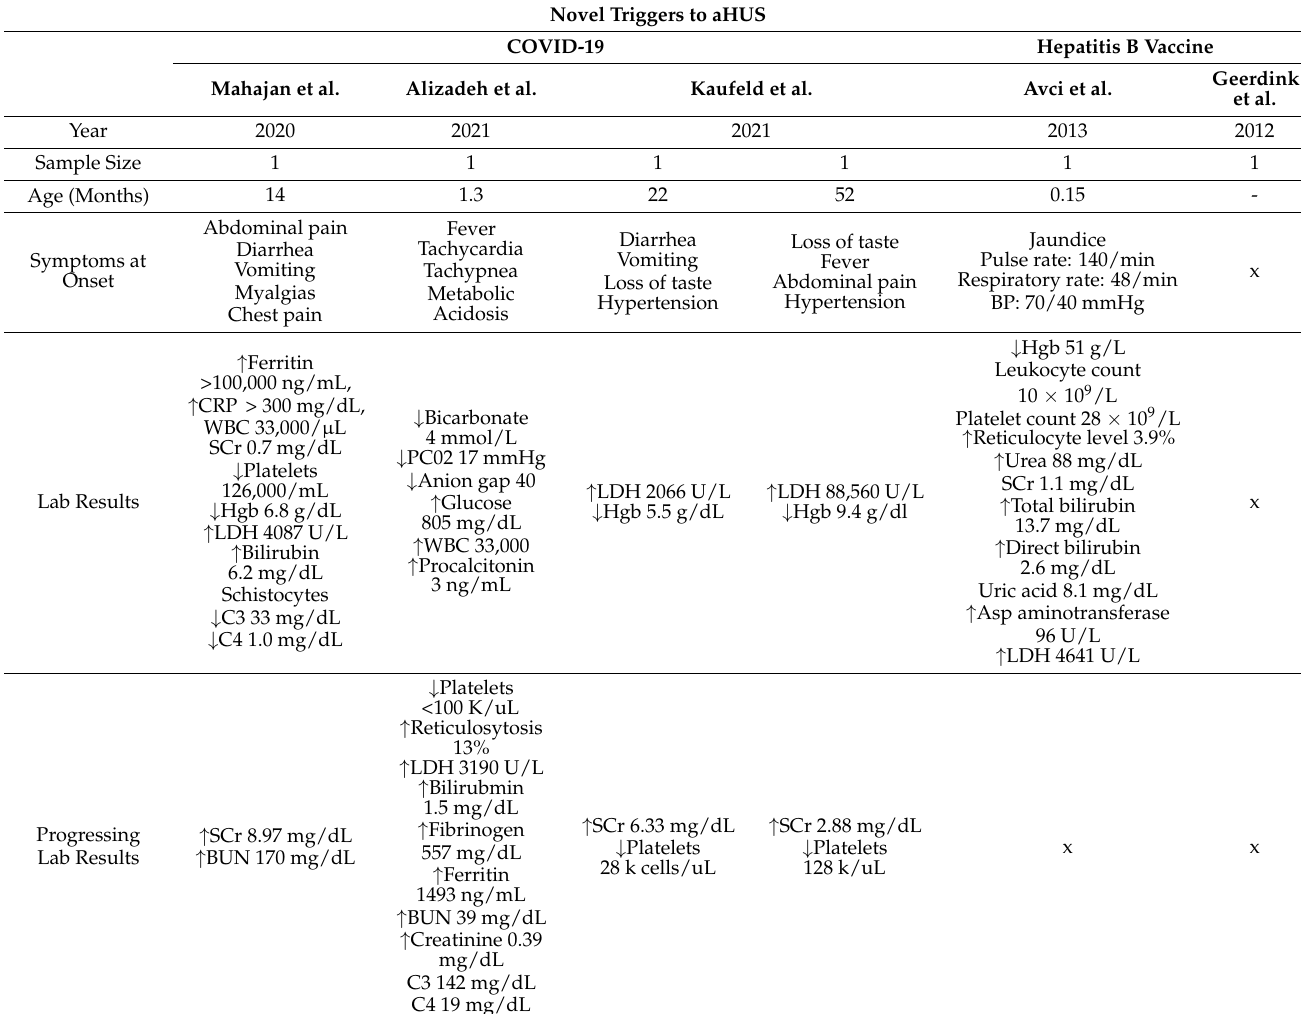
Table 2. Triggers to